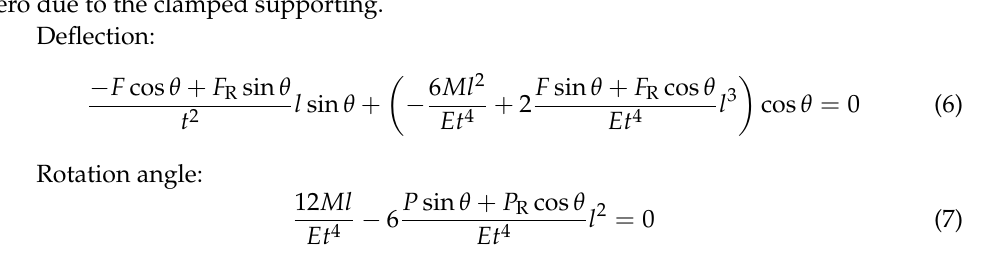
In the horizontal direction, both the displacement and rotation angle of the truss are zero due to the clamped supporting. zero due to the clamped